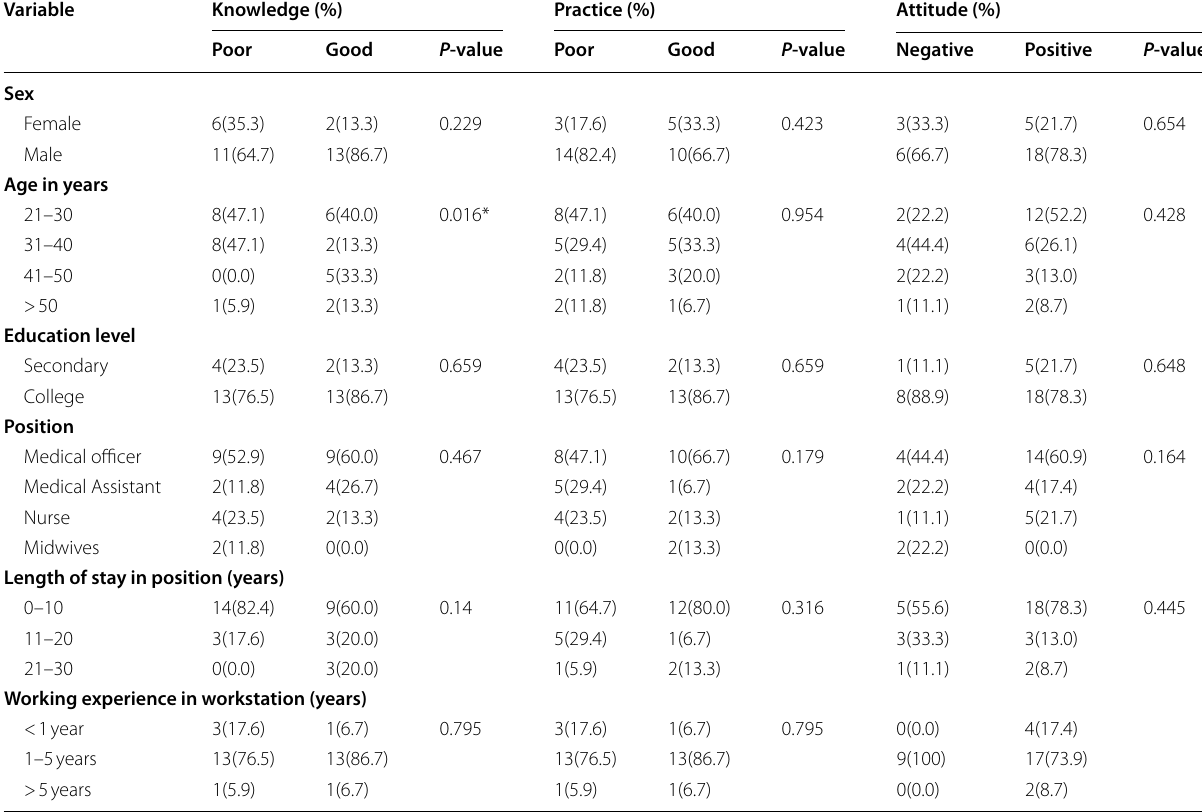
Table 2 Association between sociodemographic factors and overall knowledge, attitude and practice scores of the healthcare workers ( N 32) =